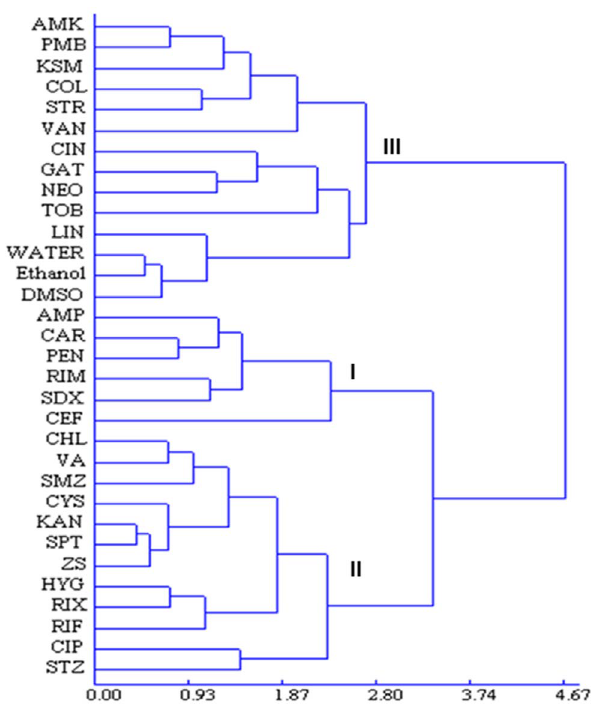
Figure 3. Dendrogram of the hierarchical cluster analysis for antibacterial activity against Las with 29 antibiotics.